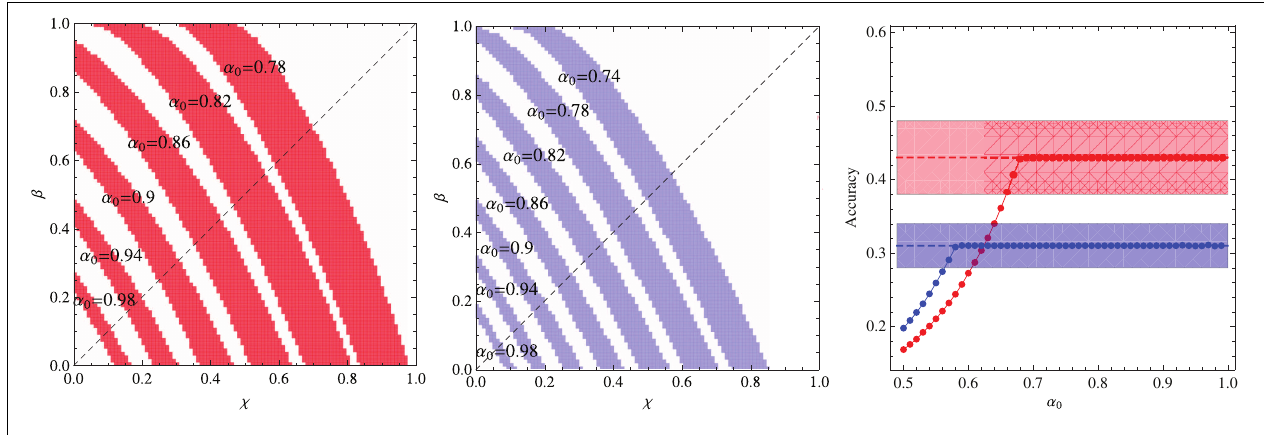
FIGURE 4 | Summary of the results of the experiments where all words co-occur without constraint and the N = 18 words are repeated exactly 6 times during the t ∗ = 27 learning trials. Left panel: Regions in the plane ( χ , β ) where the algorithm fits the experimental data for fixed α 0 and context size C = 3. Middle panel: